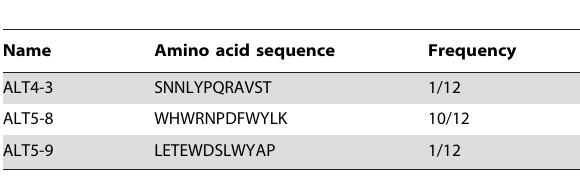
Table 1. Sequences of the 12 selected phage clones obtained following the fifth round of biopanning against